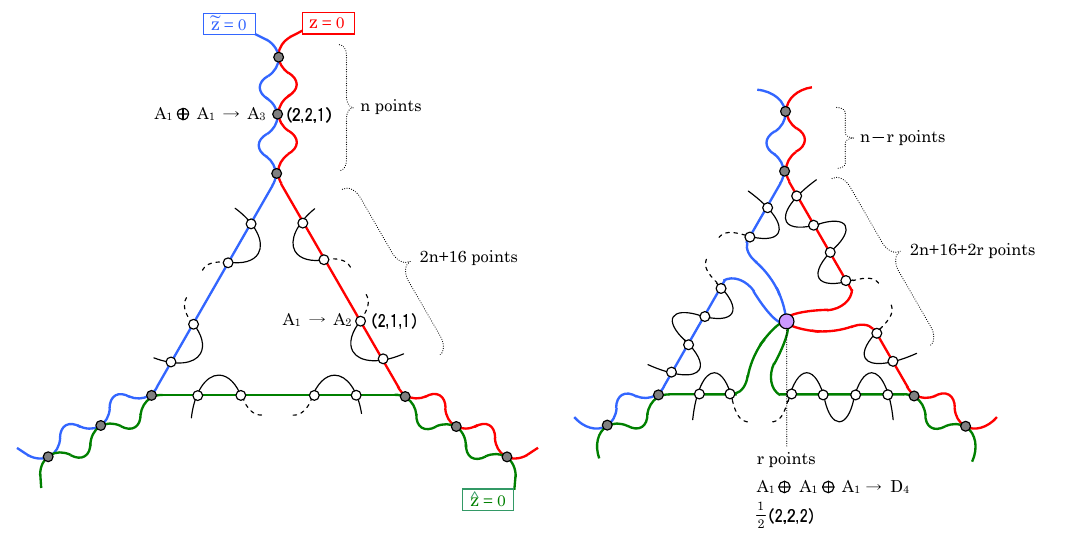
Figure 1 . Discriminant locus for G = SU(2) (cid:2) SU(2) (cid:2) SU(2) (No.7): r = 0 (left) and r 6 = 0